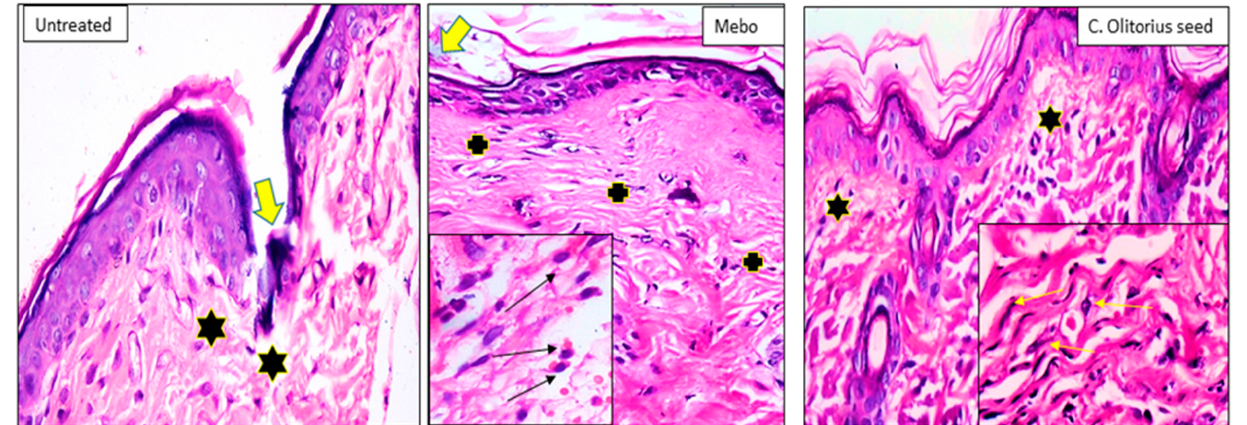
Figure 7. Wounded skin 7 days after incision; [untreated group] ( n = 8), showing the wound filled with blood clots (thick arrow) and the underlying sloughed granulation tissue with compact and disorganized collagen bundles (stars). [Mebo-treated group] ( n = 8), showing scar tissue blocking the wound (thick arrow), the underlying dermal matrix showing inflammatory cellular infiltration mainly macrophages with acidophilic cytoplasm (black arrows in the inset) and coarse wavy collagen bundles packing the defect resembling that of the adjacent normal dermis (crosses). [ C. olitorius seed-treated group] ( n = 8), Showing marked re-epithelization and the underlying regenerated papillary dermal tissue showing fine interlacing collagen bundles (stars), and in the reticular dermis appear as coarse wavy bundles with numerous fibroblasts (yellow arrows in the inset). (H & E stain × 200 and 400).